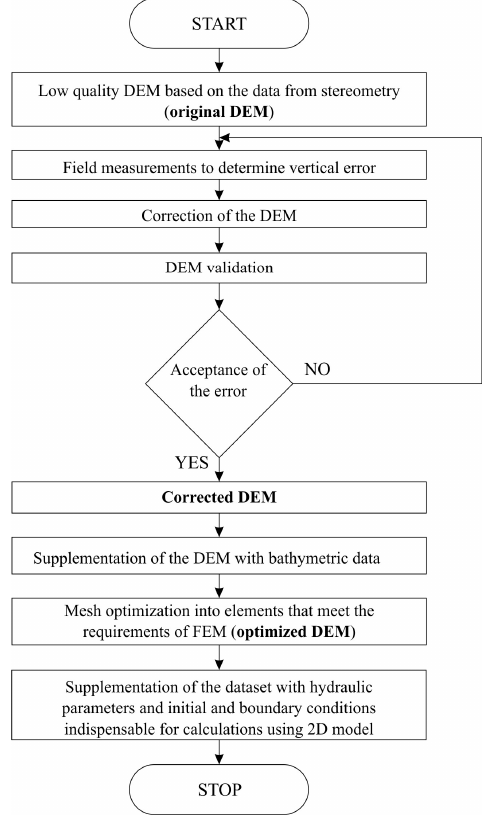
Figure 1. Flowchart for data preparation for 2D hydraulic modeling.